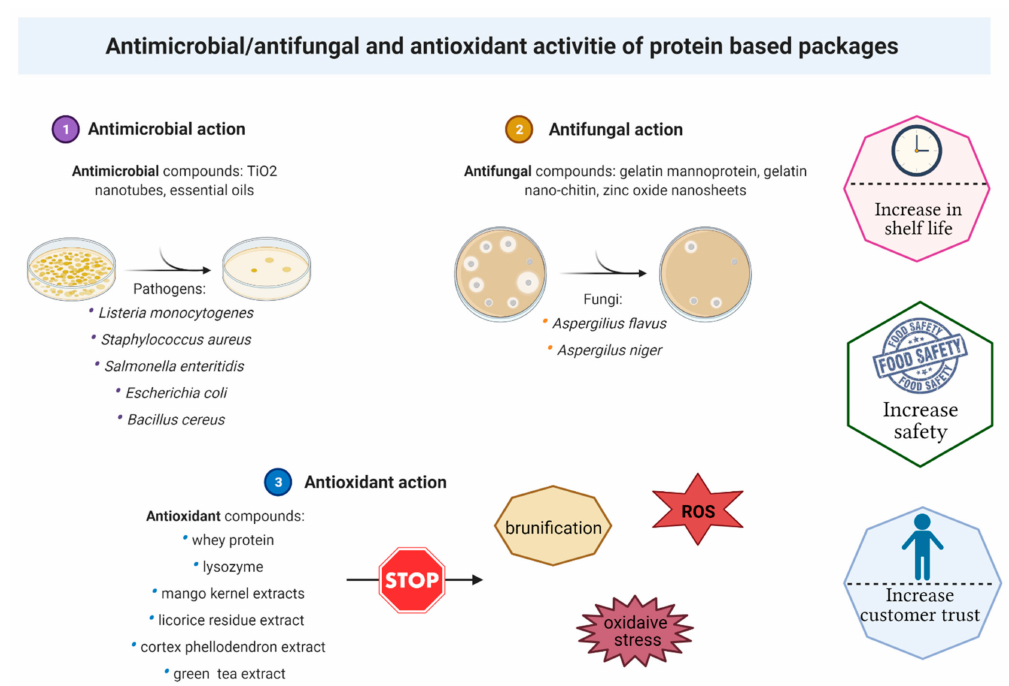
Figure 3. Protein-based packages and their additions of antimicrobial/antifungal and antioxidant